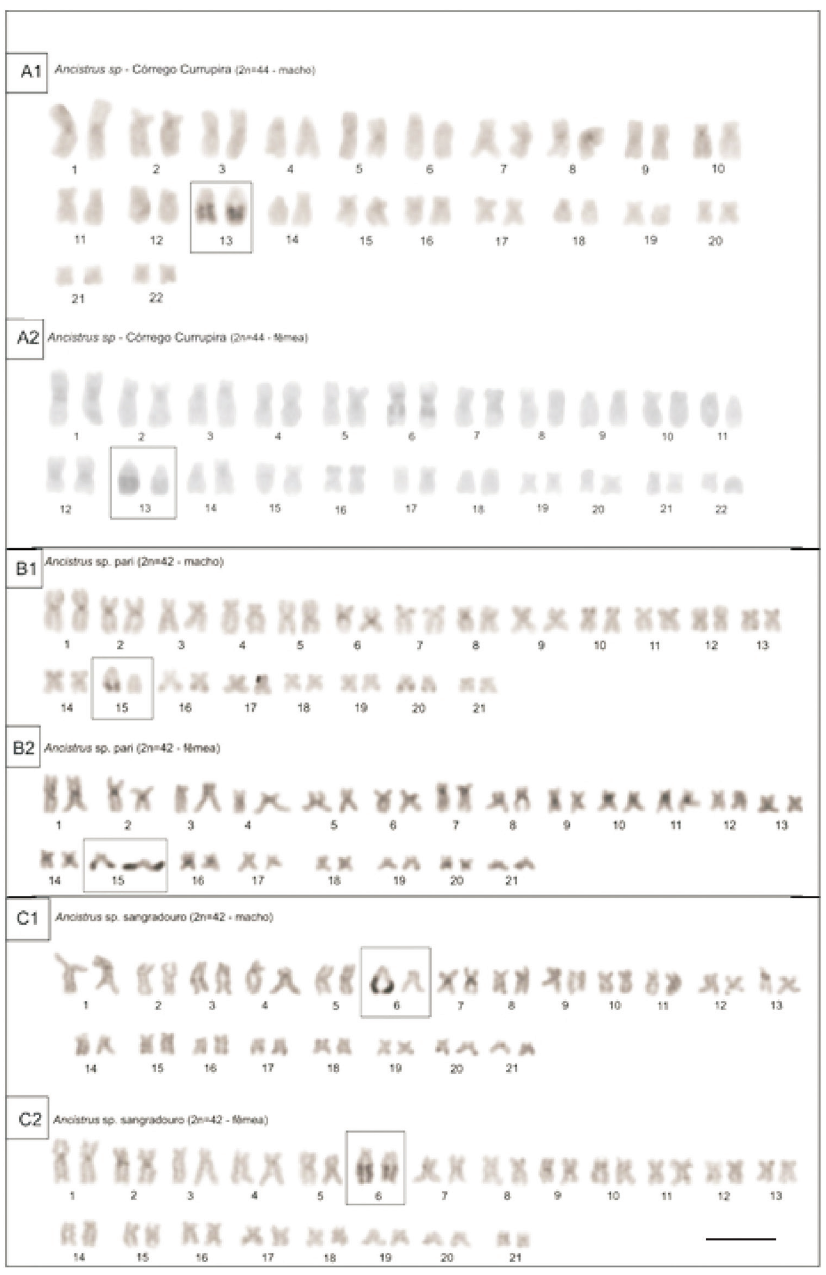
Figure 2. Karyotype after C band. Ancistrus sp. “Currupira” has 2n=44 chromosomes and showed het- erochromatin blocks mainly at centromeric regions and pair 13 ( A ), Ancistrus sp. “Pari” has 2n=42 chro- mosomes with heterochromatin blocks along centromeric regions and a big block in pair 15 ( B ) and Ancistrus sp. “Sangradouro” has 2n=42 chromosomes, a karyotype similar to Ancistrus sp. “Pari” but the big heterochromatin block is in pair 6 ( C ). Bar = 10